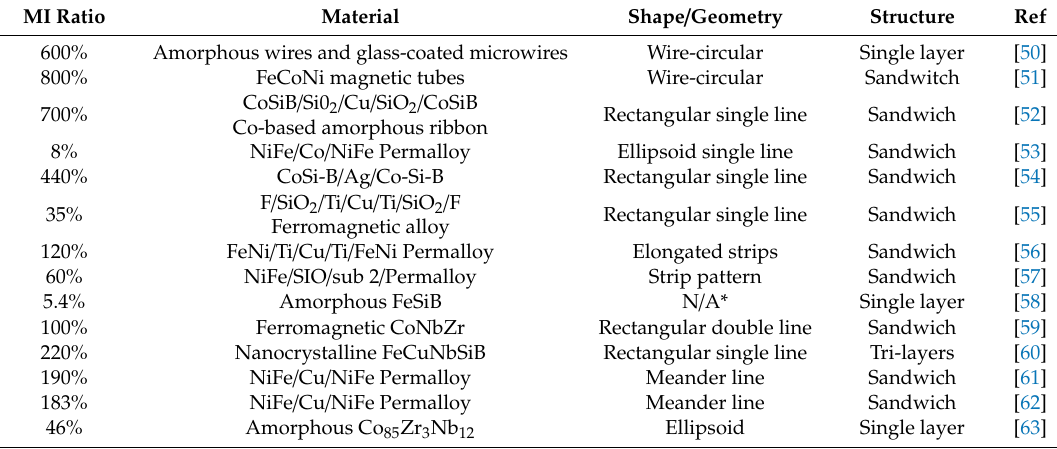
Table 1. The highest MI effect based on geometry, materials, and structure.